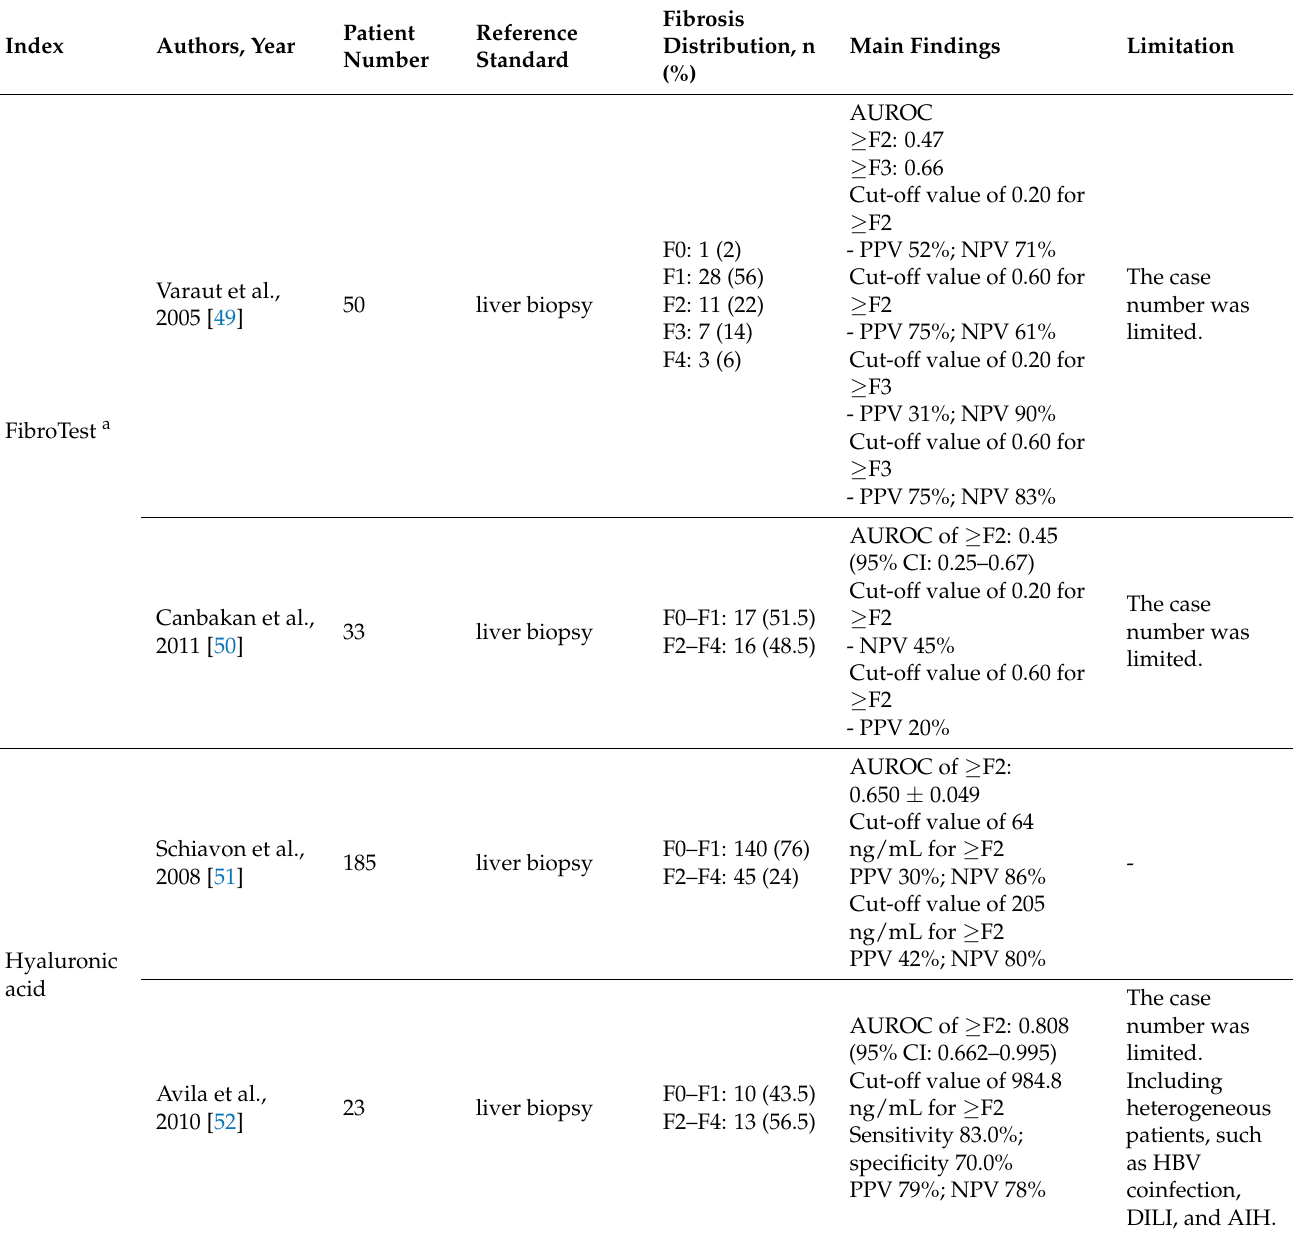
Table 2. Summary of serological indices to predict hepatic fibrosis in hemodialysis patients with HCV